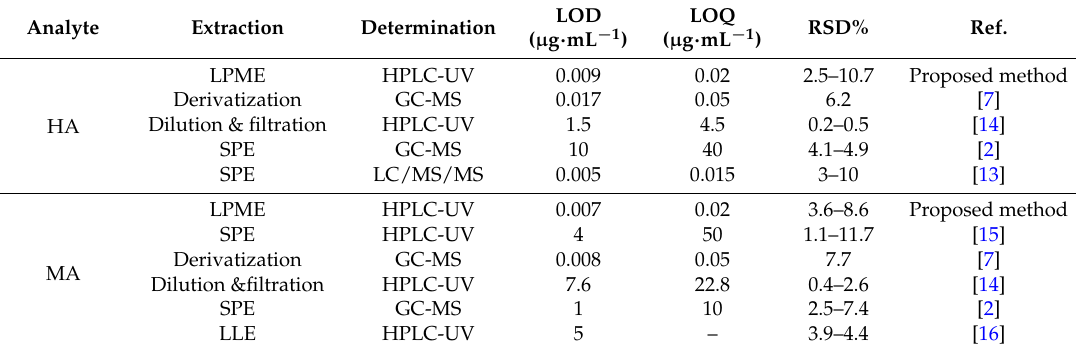
Table 4. Comparison of the HF-LPME–HPLC method compared to other reported conventional methods for extraction and determination of MA and HA in human